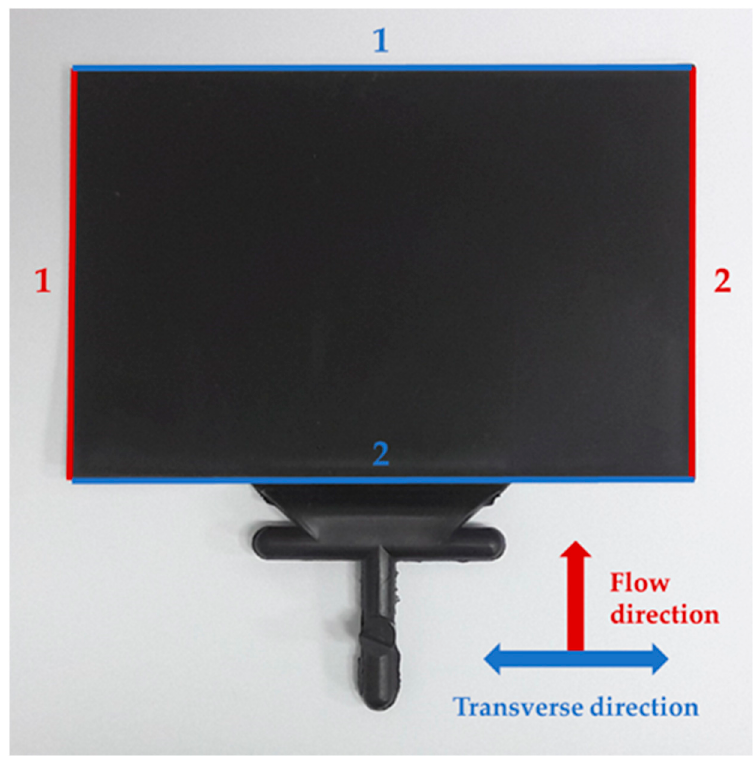
Figure 1. Shrinkage measurement positions of the test specimen.